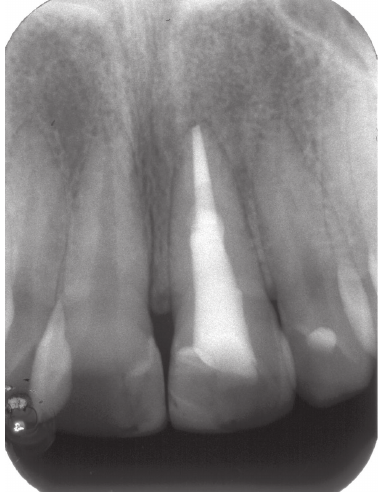
Figure 14: Radiograph at 1 year.